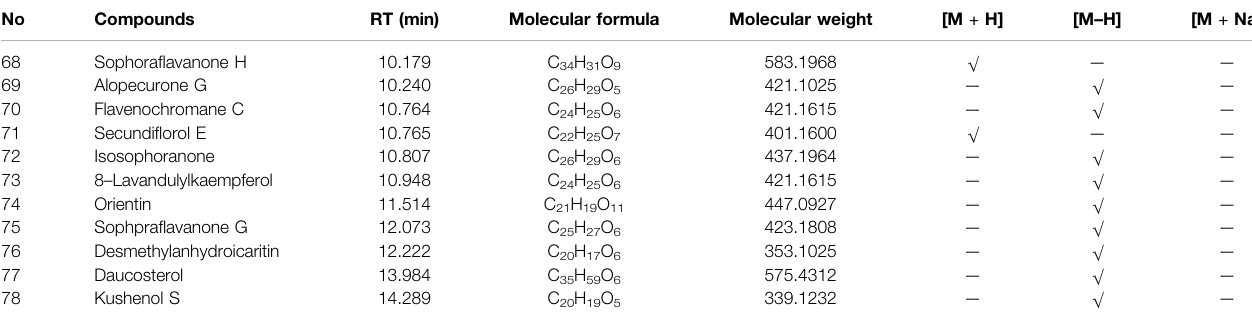
group was orderly and compact, with complete morphology. SDE could inhibit the apoptosis of hippocampal neurons and improve the D – gal – induced brain aging. iNOS Activity in Serum Compared with the NC group, the level of iNOS in the D – gal group increased signi fi cantly ( p < 0.01; Figure 3 ) and the activity of iNOS in the SL group decreased, but there was a signi fi cant difference between the NC group and SL group ( p < 0.01). Compared to the D – gal group, the iNOS activity in the SH group and the Vc group decreased signi fi cantly ( p < 0.01).